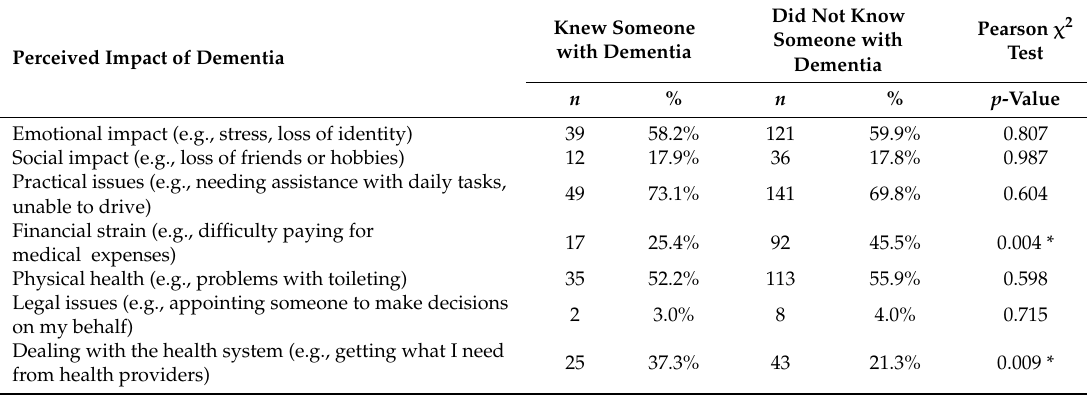
Table 3. Comparison of the perceived impact of dementia to others between respondents knowing someone with dementia in the past 5 years and those did not (select up to 3